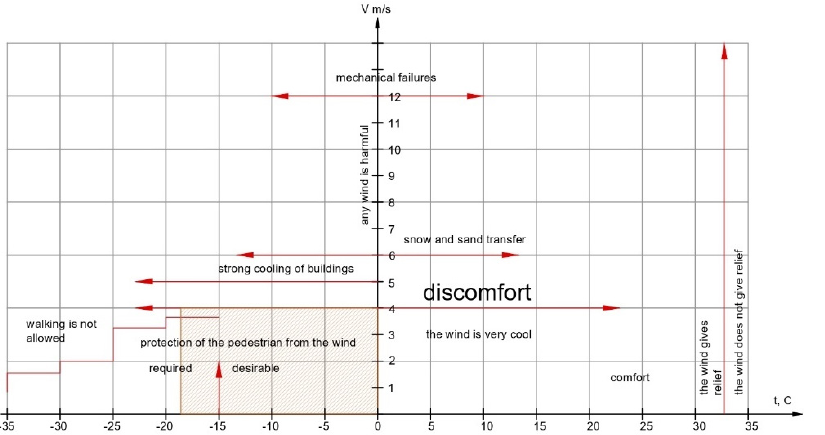
Figure 7. Determination of the boundary velocity for a theoretical study on the aeration regime in the residential development on sloping lands of the AZRF.